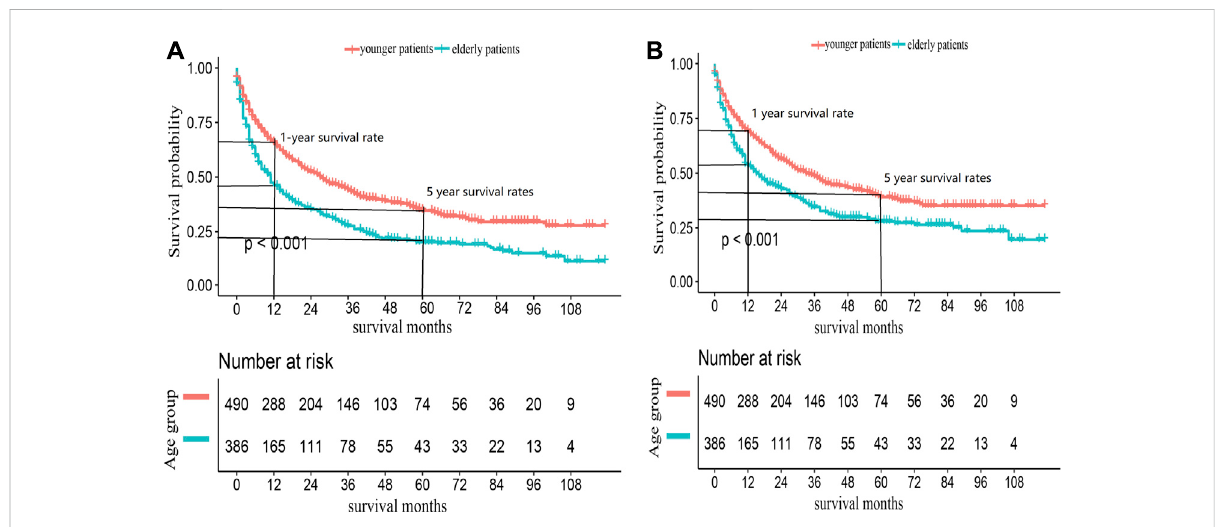
FIGURE 2 Kaplan-Meier survival curves for (A) OS and (B) CSS in ACC patients, according to age